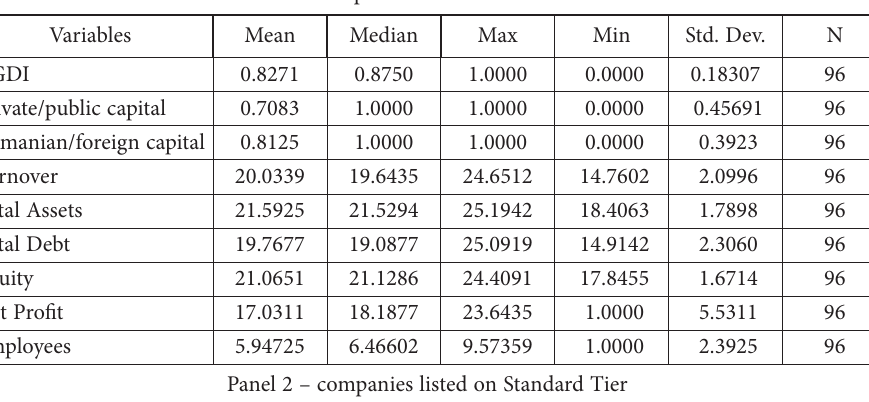
Table 1. Descriptive statistics (source: authors’ own calculation using Eviews software) Panel 1 – companies listed on Premium Tier